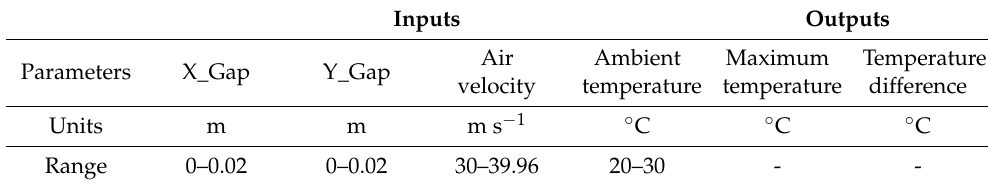
Table 3. Details of the inputs and outputs for the ANN